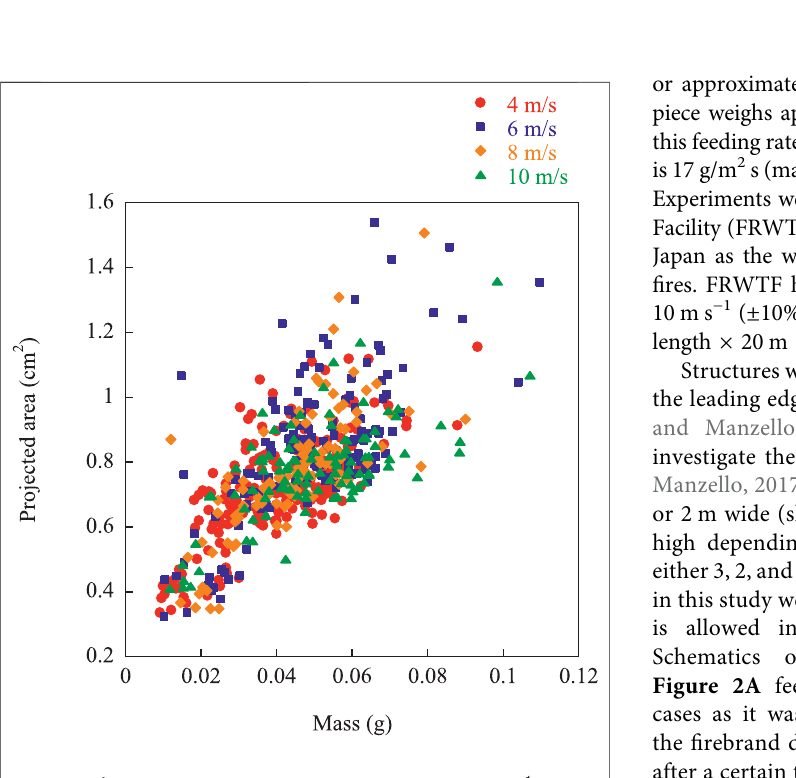
Frontiers in Mechanical Engineering |